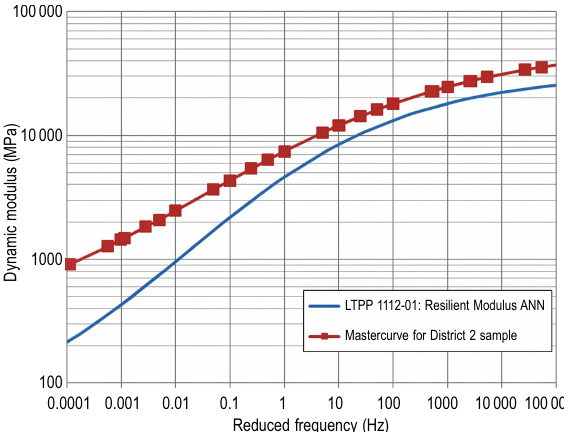
Fig. 5. Dynamic modulus mastercurves from laboratory tests and LTPP database for New Mexico District 2